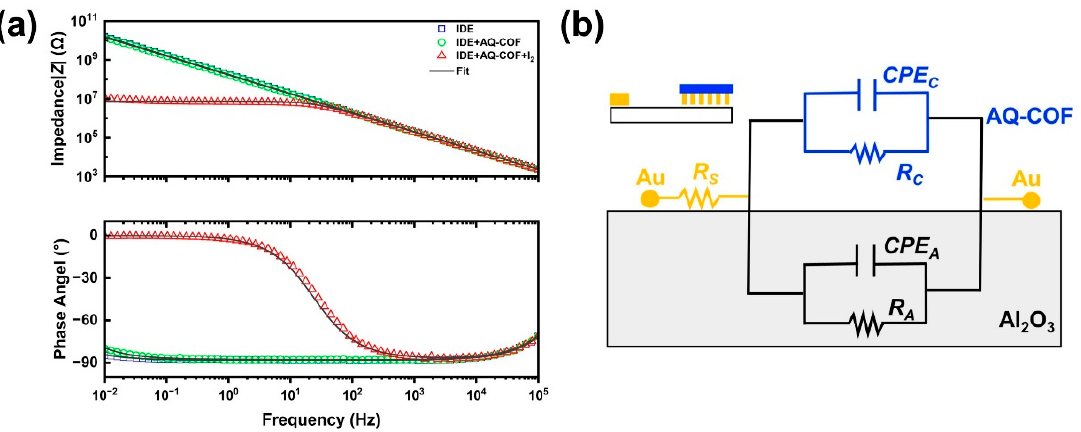
Figure 2. ( a ) Impedance and phase angel of pristine IDE and AQ-COF coated IDE under different conditions as a function of frequency. ( b ) A simplified equivalent circuit model of the electrical system.